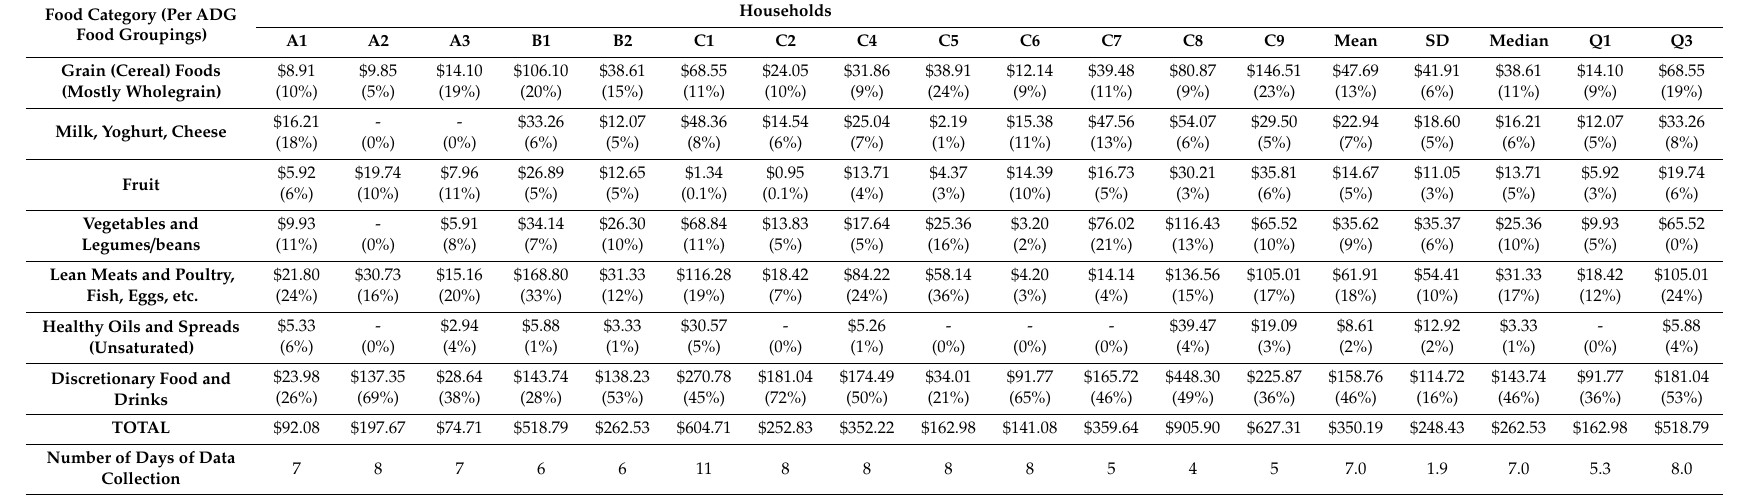
Table 2. Household expenditure on food and drinks (by Australian Dietary Guidelines [ADG] categories)—amount ($) and proportion of total spend (%). Food Category (Per ADG Food Groupings)